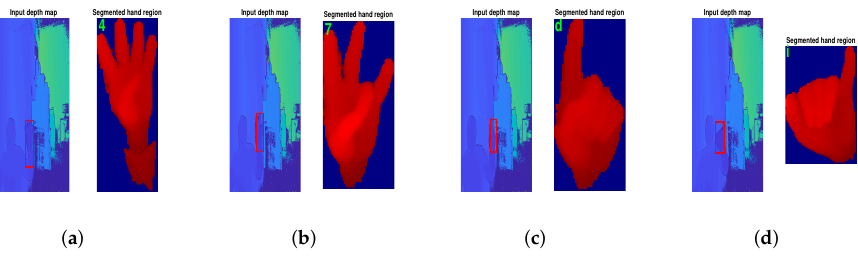
Figure 9. The hand region part is segmented from the input depth map, and the recognized gesture pose is displayed in the figure. ( a – d ) are different detected real-time gesture poses of ‘4’, ‘7’, ‘d’, and ‘i’ respectively using proposed